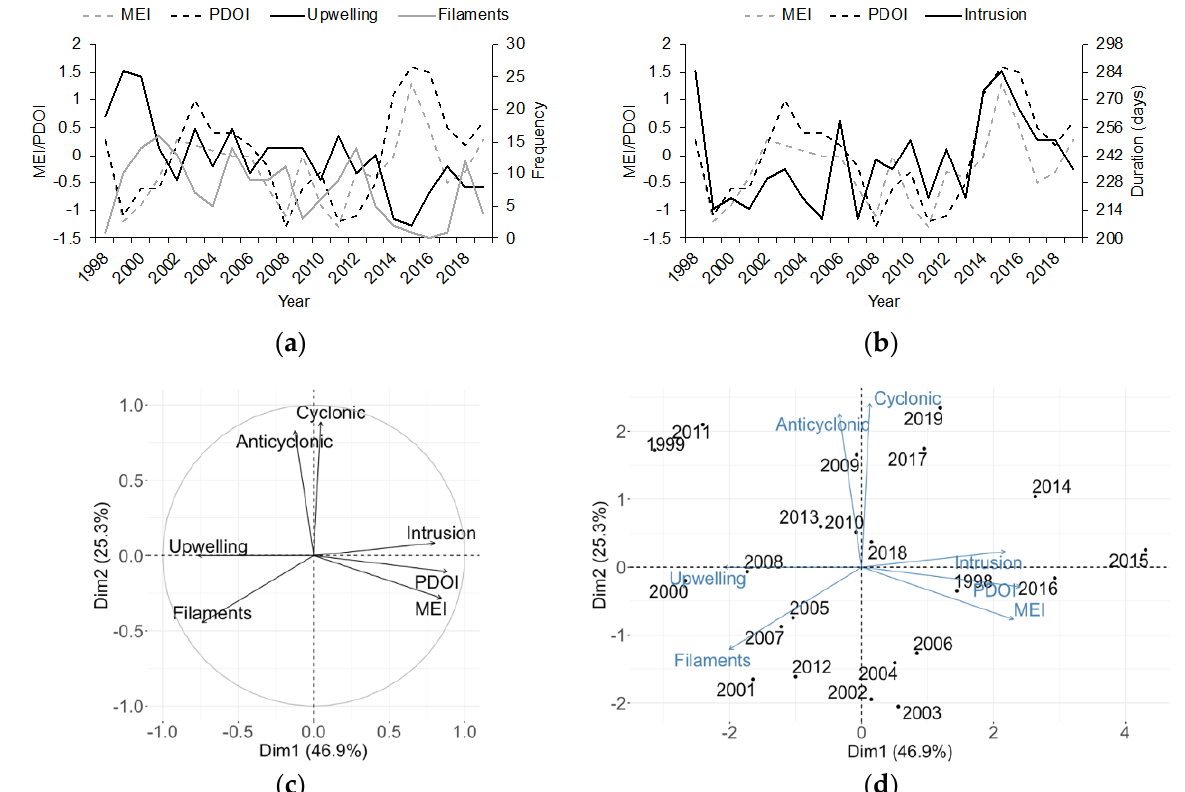
Figure 13. The Multivariate El Niño Index (MEI) and the Pacific Decadal Oscillation Index (PDOI) with the interannual variability in the Southern Gulf of California of ( a ) coastal upwelling and filament frequency; ( b ) water mass intrusion duration. Principal component analysis of oceanic mesoscale events, the Multivariate El Niño Index and the Pacific Decadal Oscillation Index in the Northern Gulf of California; ( c ) Contribution of mesoscale events and climate indices to the first two principal components; ( d ) Contribution of each year (1998–2019) to the first two principal components.